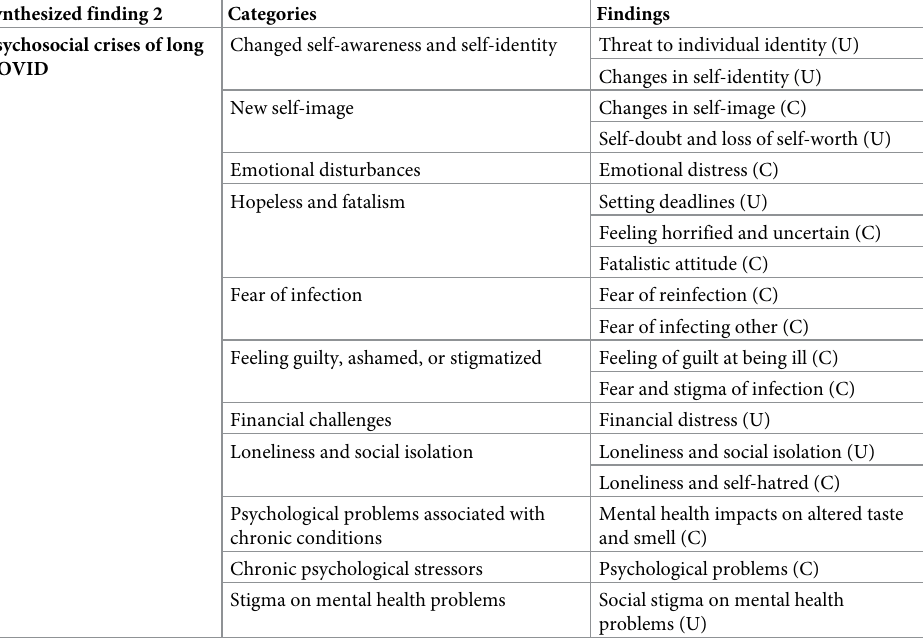
Table 4. Findings and categories within synthesized finding